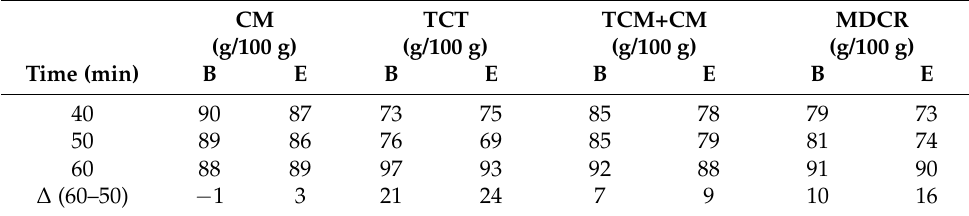
Table 4. The protein concentration (g/100 g) in dried hydrolysates resulting from Bromelain (B) and Endocut-02 (E) hydrolysis (Dumas nitrogen x 6.25) from samples taken at 40 and 50 min of hy- drolysis, and from the final dried hydrolysate at 60 min (mean value of duplicate hydrolysate series). In the lower row, the difference in protein concentration between the 50 min sample and the 60 min